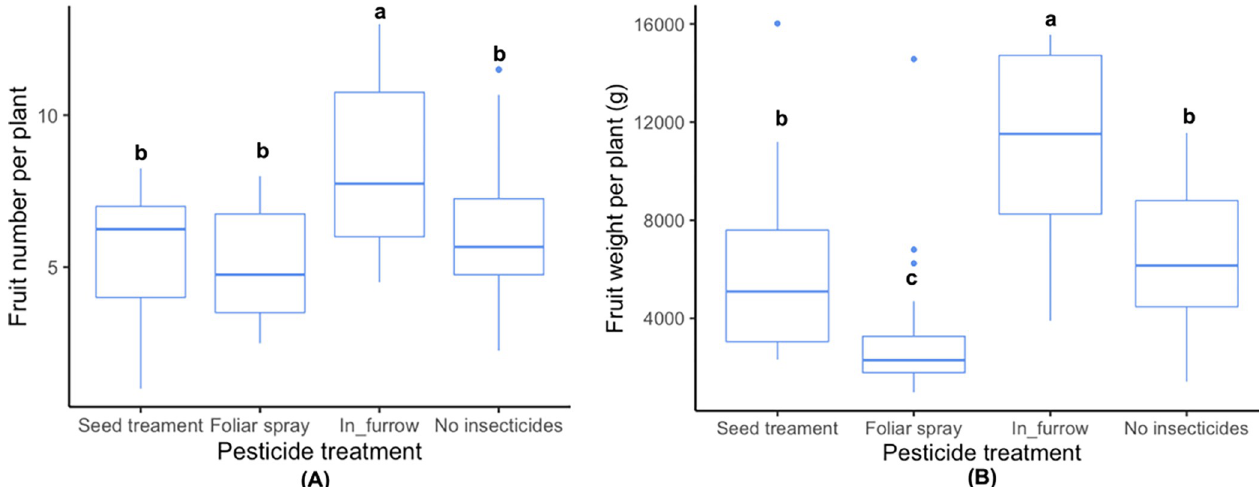
Fig 3. Effect of different thiamethoxam application methods on (A) fruit number and (B) fruit weight per plant in squash crops. Whiskers indicate the range of numbers and weights of fruits harvested, excluding outliers. Upper, middle, and lower quartiles indicate the greatest, average, and lowest fruit numbers and fruits weights quantified, respectively. Different letters indicate significant differences between levels of the treatment based on Tukey’s HSD post-hoc test (p < 0.05).